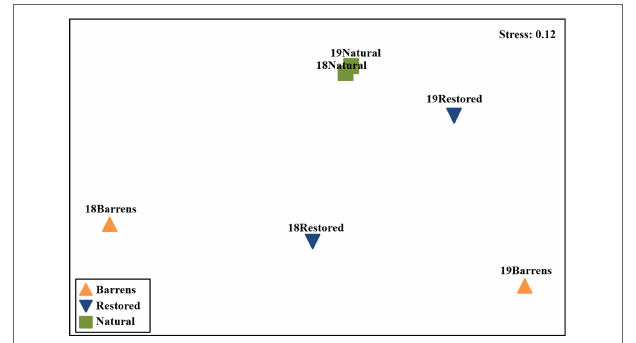
FIGURE 3 | Multidimensional scaling analysis for comparing macroalgae assemblages based on Bray–Curtis similarities of square-root-transformed total